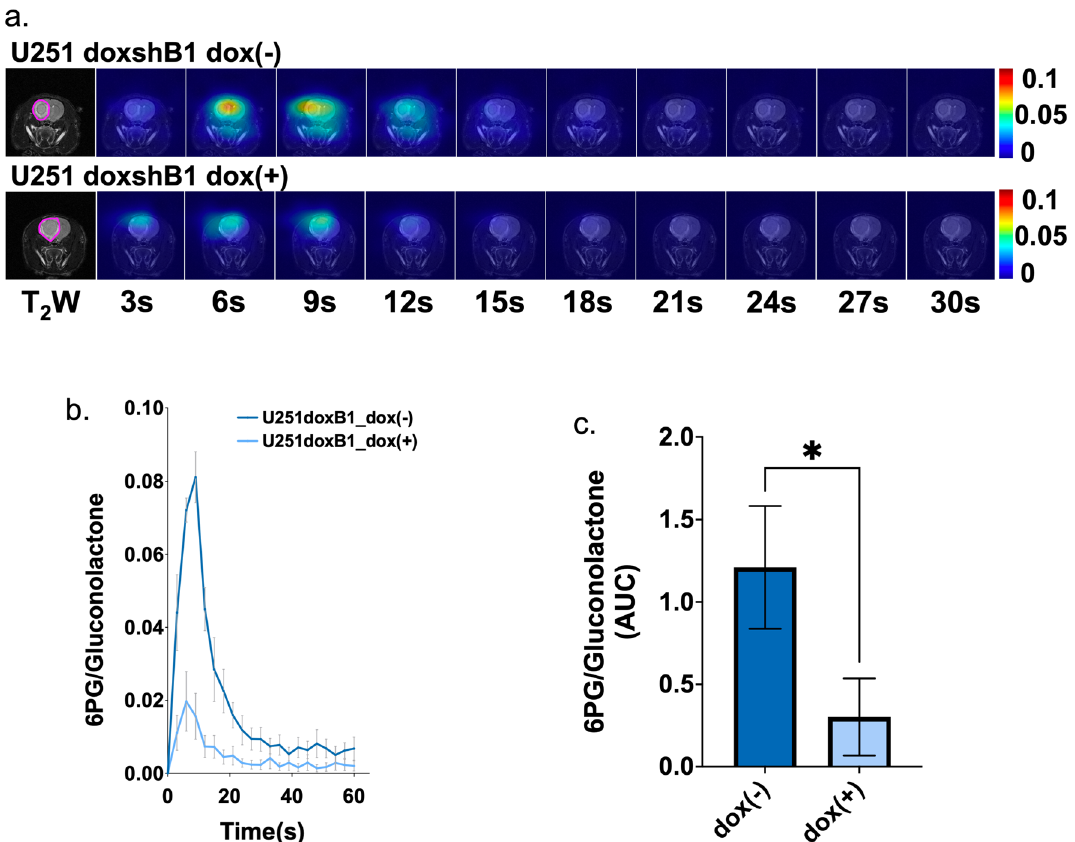
Figure 7. ( a ) Dynamic hyperpolarized 13 C echo-planar spectroscopic imaging data set of [1- 13 C]6PG acquired with 3 s temporal resolution. ( b ) Temporal evolution of [1- 13 C]6PG comparing U251doxshB1 tumors prior to (dox( −)) and following (dox( +)) doxycycline. ( c ) The AUC of [1- 13 C]6PG comparing U251doxshB1 tumors prior to (dox( −)) and following (dox( +))